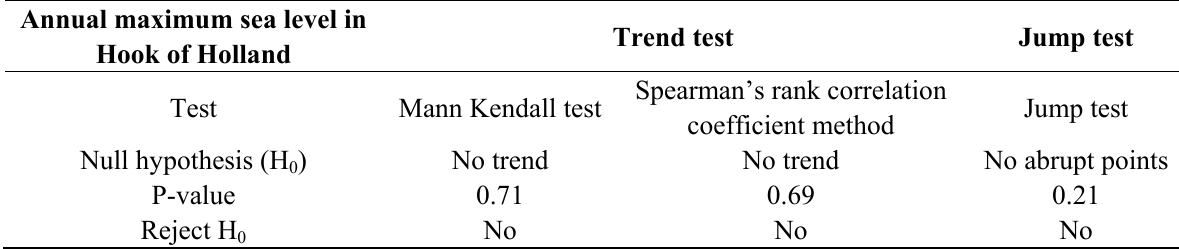
Table 3. Tests on the corrected annual maximum sea level at Hook of Holland.